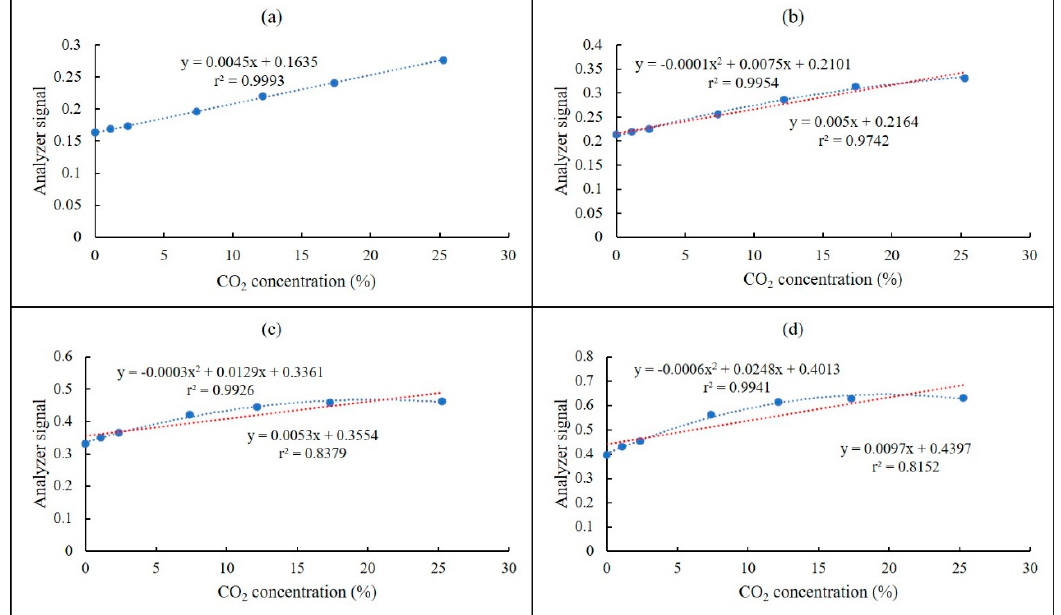
Table 2. Lower detection limits with respect to various